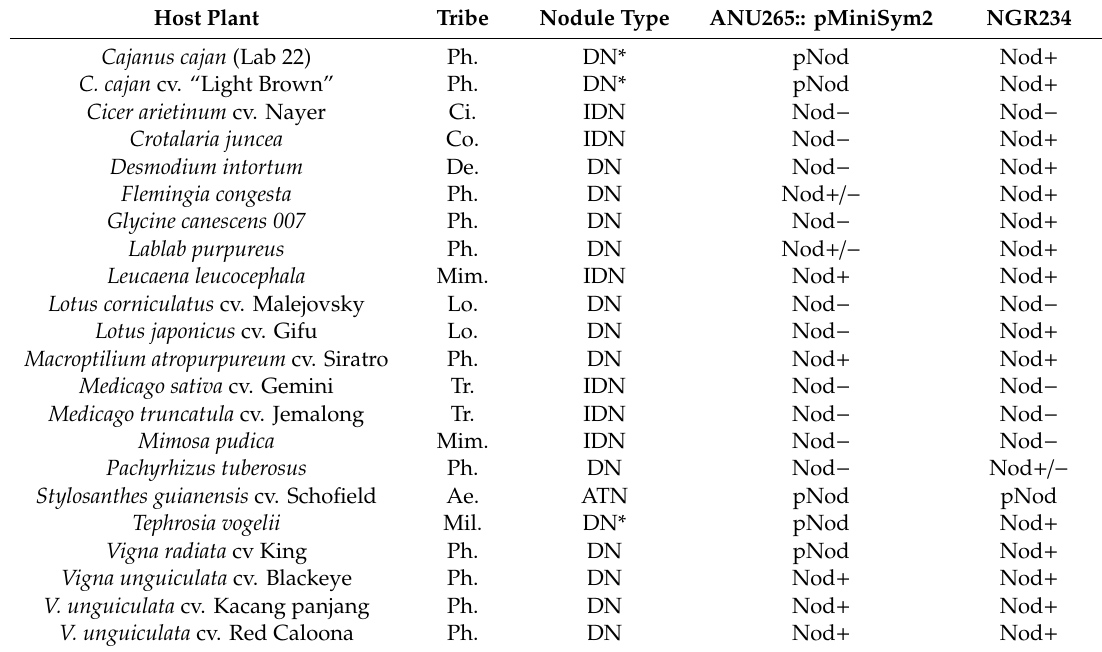
Table 1. Host-range of ANU265::pMiniSym2. Symbiotic phenotypes reported here correspond to the capacity of strains to form mature-like nodules (Nod + ), pseudonodules (pNod) or no nodule at all (Nod-) after 28 days post-inoculation. Nod +/ − refers to mature-like nodules formed on some of the inoculated roots. Legume species that were Nod- or pNod with ANU265::pMiniSym2 were assayed once. By contrast, at least seven consecutive nodulation assays were conducted on cowpea, L. leucocephala and siratro. Plants that were non-inoculated or inoculated with ANU265 never showed any nodule development. Phenotypes of NGR234 were consistent with those reported in [41,71]. S. guianensis cv. Schofield makes nodules of aeschynomenoid type (ATN). Previously thought to form indeterminate nodules (IDN), C. cajan and T. vogelii were recently reported to make determinate nodules (DN) with secondary clusters of dividing cells (DN*) [10]. Legume tribes are abbreviated as